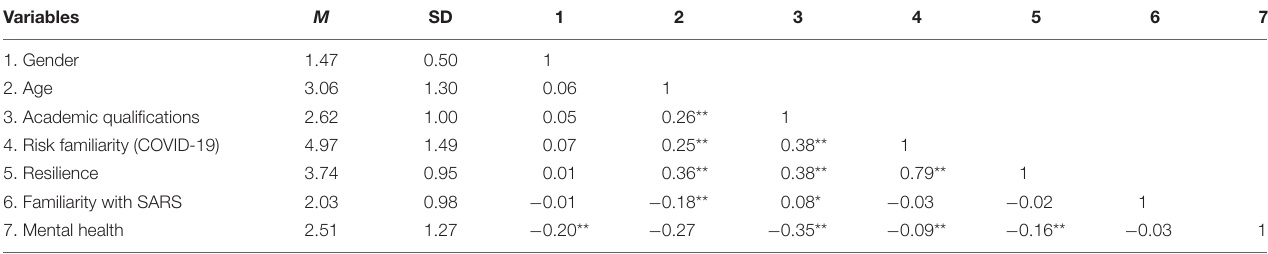
TABLE 1 | Descriptive statistics and correlation coefficient matrix of the variables. Variables